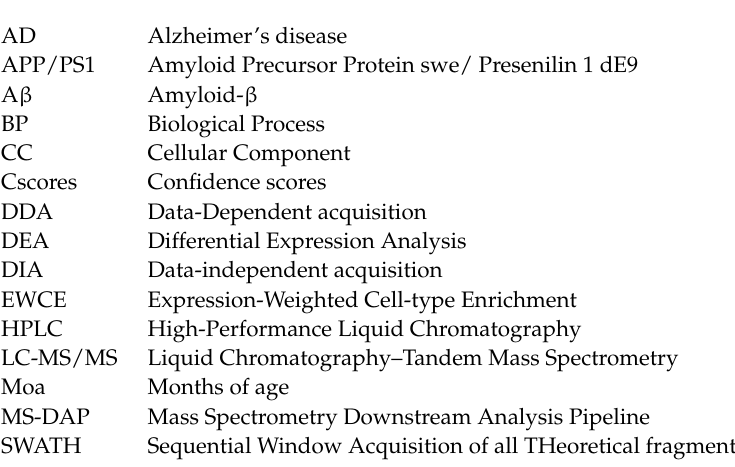
10.3390/cells10071588/s1, Figure S1: Enrichment of synaptic proteins in the synaptosomal sample preparation. Figure S2: Target (blue) and decoy (grey) confidence score distributions of all 12-moa samples searched against the DDA-based spectral library; Figure S3: Number of identified and quantified proteins and peptides with a q -value ≤ 0.01 for identification; Figure S4: Target (blue) and decoy (grey) confidence score distributions of all 12-moa samples searched using directDIA; Figure S5: Characterization of unique and shared peptides identified using the spectral library or directDIA data searches; Figure S6: Abundance of shared and uniquely identified proteins using the spectral library or directDIA after filtering high quality peptides for differential expression analysis; Figure S7: Quality control in MS-DAP of wildtype 1 in the 6-moa dataset; Figure S8: Quality control of the 6-moa dataset run against the directDIA library and comparison with the 12-moa dataset; Figure S9: Sunburst plots of SynGO terms with highlighted gene counts of regulated 6- or 12-moa APP/PS1 mouse genes; Figure S10: Gene expression cell-type specificity matrix of upregulated proteins in synaptosomes of 12-moa APP/PS1 mice; Table S1: Regulated proteins that have been associated with AD in previous human studies; Table S2: SynGO annotations of regulated proteins at 6- or 12-moa APP/PS1 mice; Table S3: SynGO enrichment analysis of synaptic proteins regulated in 6- or 12-moa APP/PS1 mice using location terms; Table S4: SynGO enrichment analysis of synaptic proteins regulated in 6- or 12-moa APP/PS1 mice using function